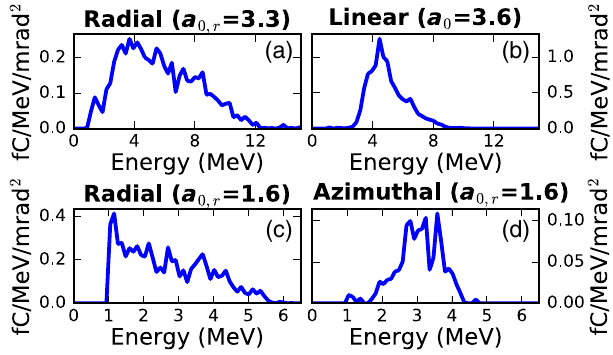
FIG. 8. Results from 3D PIC simulations. Electron energy distributions are computed in a 30-mrad cone at the angle defined by the black circles shown in Fig.